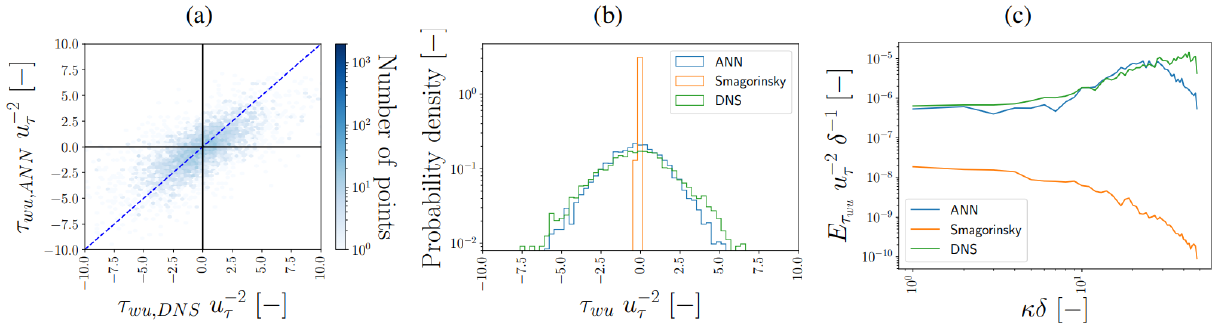
( 55 . 3125 z + ) ) for a representative flow field not used Figure 8. Performance of τ wu, ANN (with n hidden = 64) in the log layer (0 . 09375 z δ to train and validate the ANNs. Panel (a) shows the corresponding hexbin plot between τ wu, ANN and τ wu, DNS , where the dotted blue line indicates the 1 : 1 line. Panel (b) shows the probability density functions and panel (c) the stream-wise spectra averaged in the span-wise direction. τ wu, ANN and τ wu, DNS have been normalized by the friction velocity u − 2 τ . The power spectral density E on the vertical axis in panel (c) has been normalized by δ − 1 and u τ − 2 . As a reference, in panels (b) and (c) , τ wu, smag is shown as well.